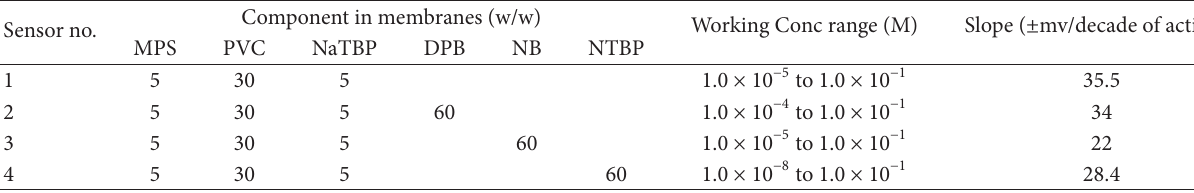
T 1: Composition of PVC membrane of (MPS) and performance characteristics of Mg 2+ -selective sensors based on them. Sensor no.